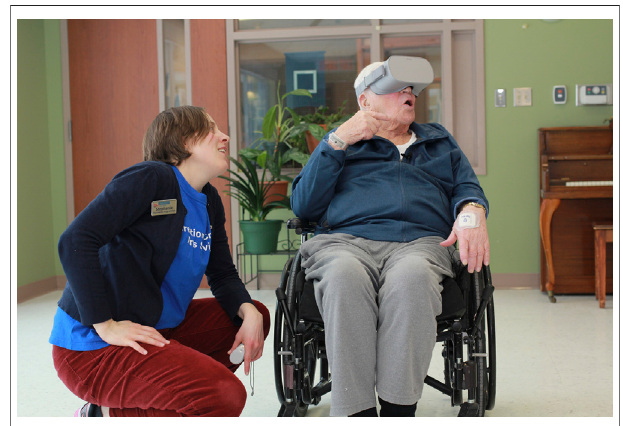
FIGURE 1 | Recreational therapist from the Perley Rideau helps a senior experience VR through an Oculus Go HMD.